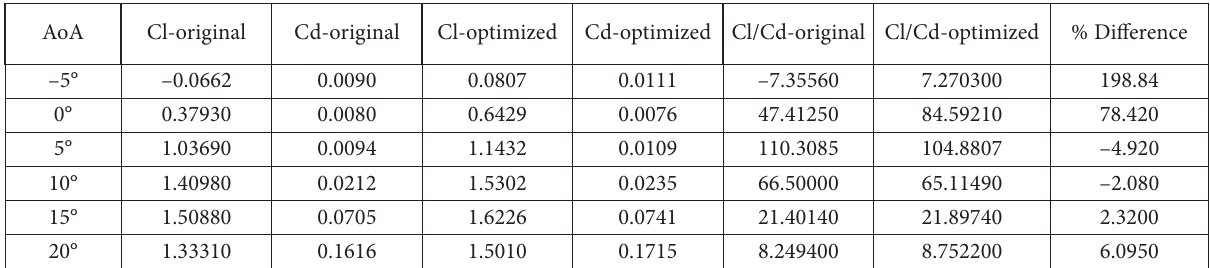
Figure 5. Graphical representations for original and optimized NACA 4415 airfoils obtained from ANSYS and XFOIL data used for validation: a) coefficient of lift at the various angle of attacks b) relation between the lift and drag coefficients Table 3. XFOIL simulation results